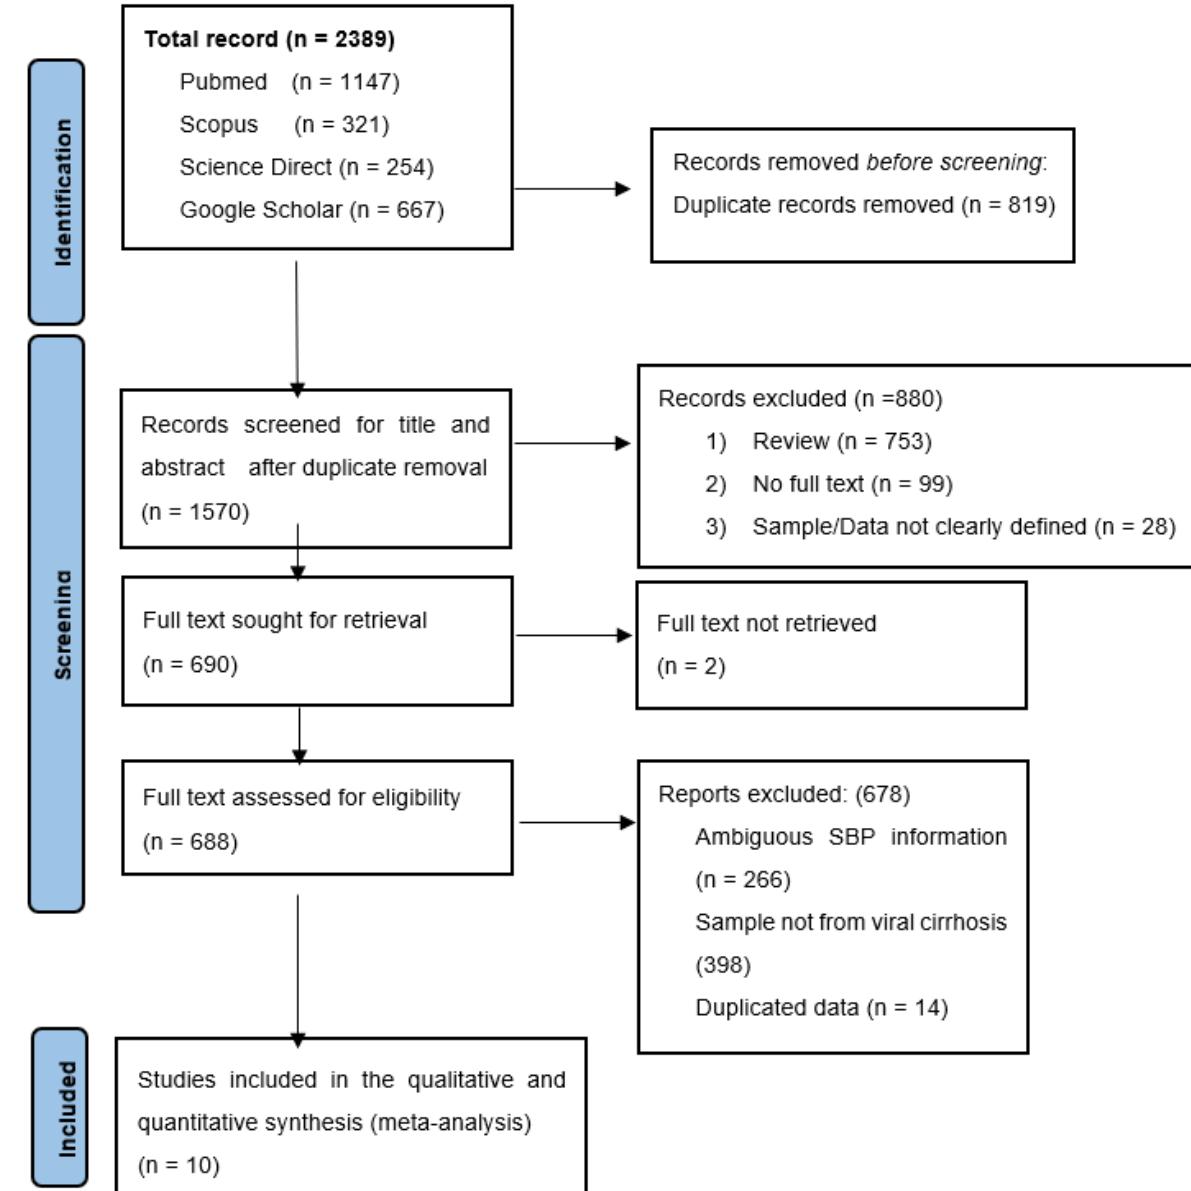
Figure 1. Summary of the article selection process.